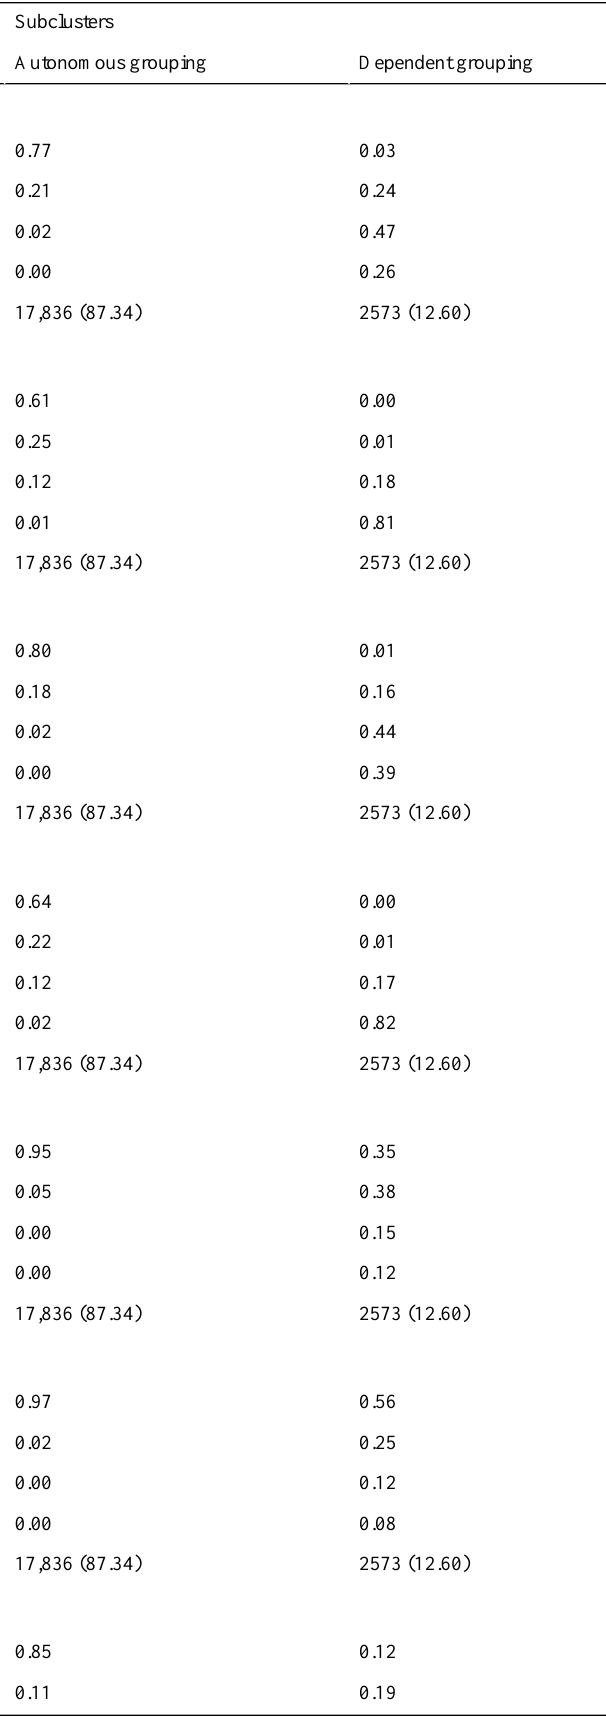
Table 5. Distribution of the capacities for the activities of daily living subcluster (N=20,422). SubclustersActivities of daily living Upper-body care